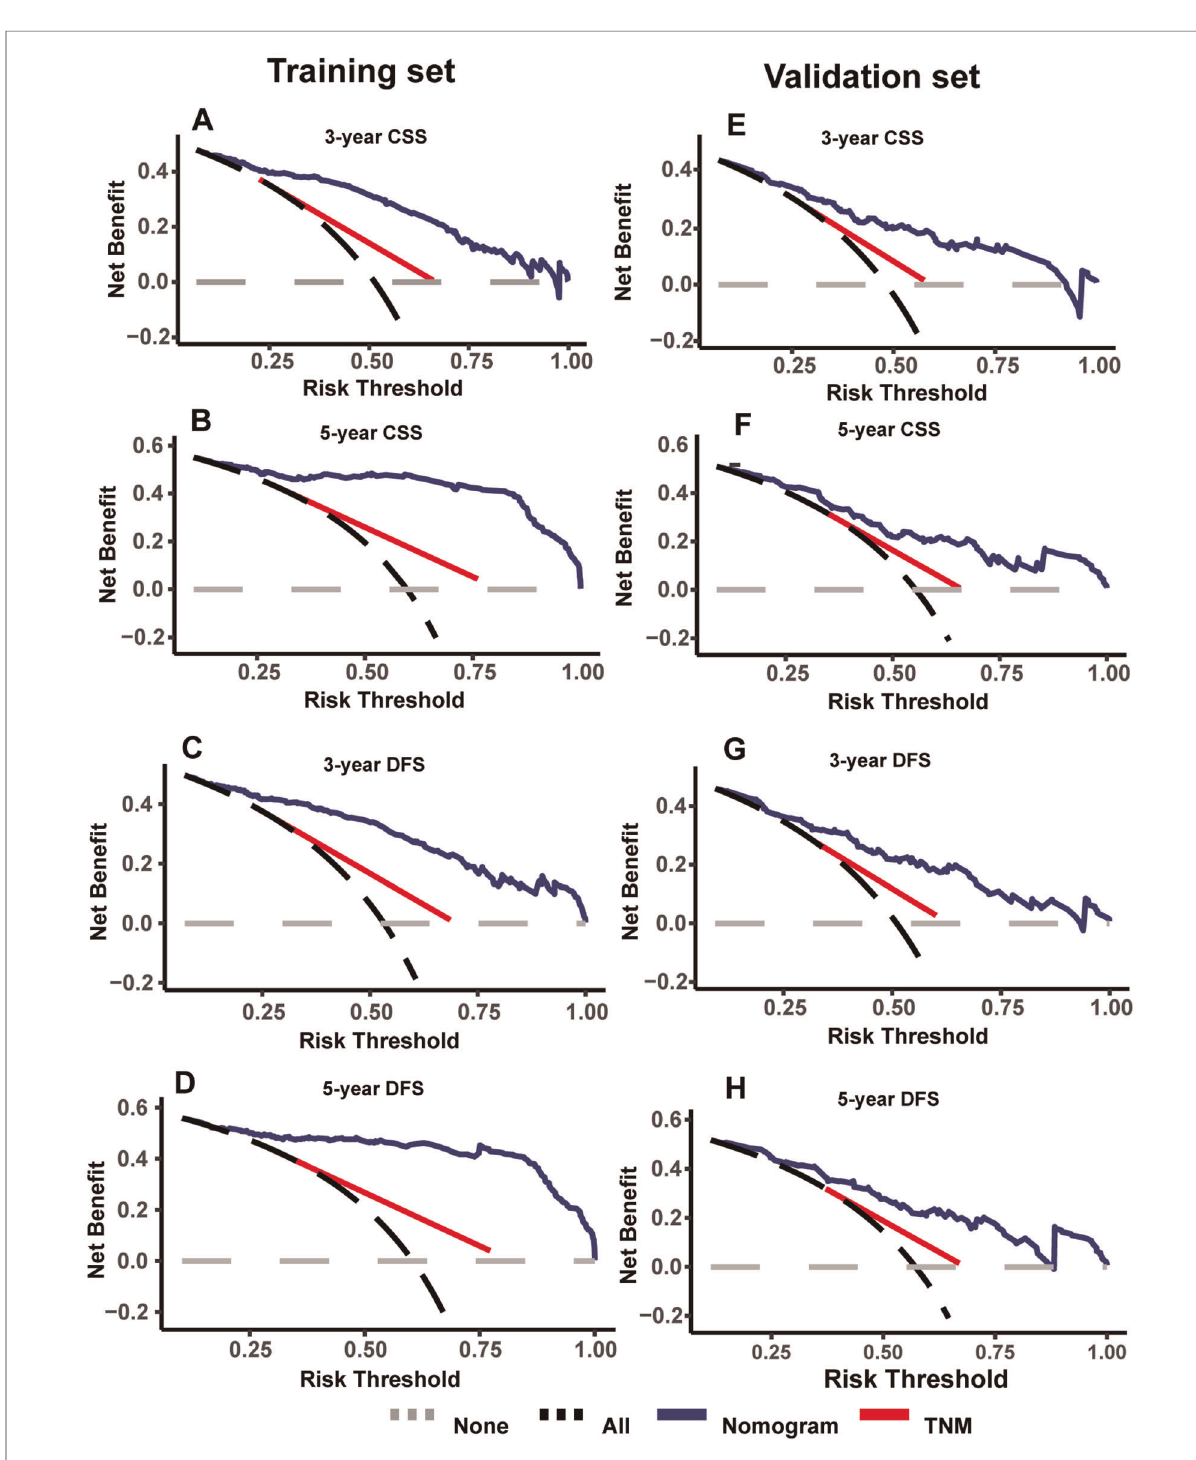
FIGURE 4 Decision curve analysis were used to compare the clinical bene fi t of nomogram and TNM staging in cancer-speci fi c survival (CSS) ( A,B ) and disease- free survival (DFS) ( C,D ) in the training set; decision curve analysis were used to compare the clinical bene fi t of nomogram and TNM staging in CSS ( E,F ) and DFS ( G,H ) in the validation